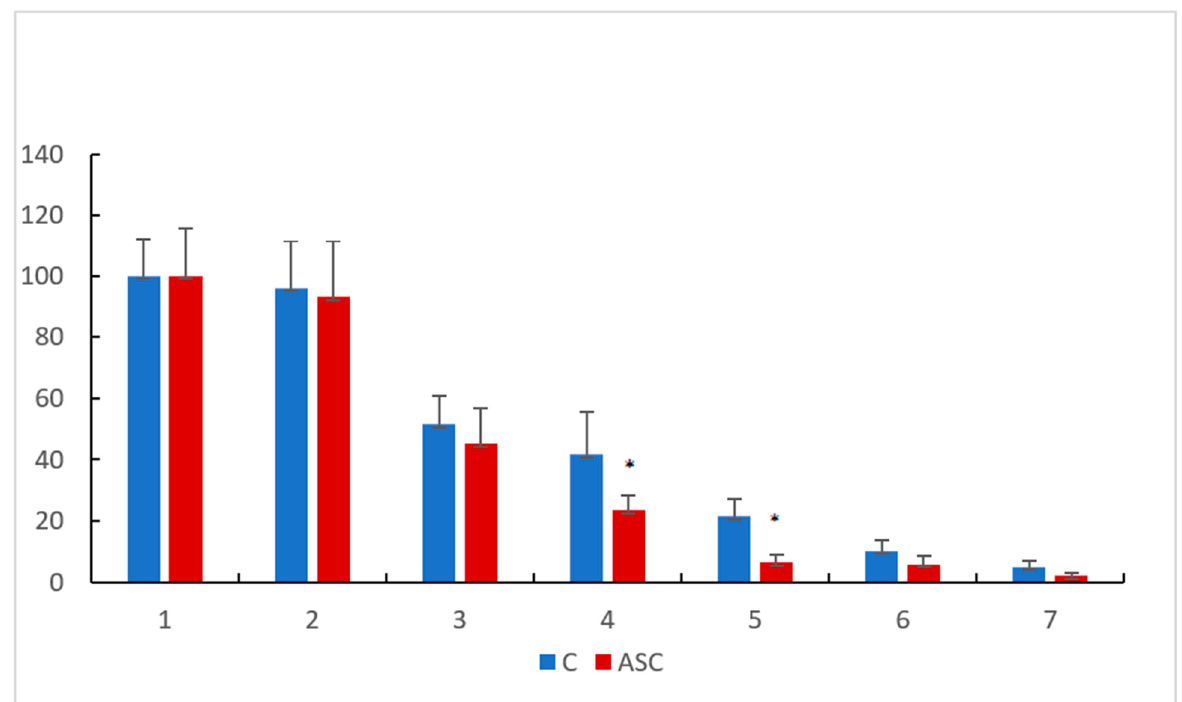
Figure 1. The surface area (in pixels) of the damaged cornea ( Y -axis) vs to time (days, X -axis) staining with fluorescein. The field of primary n -heptanol damage was assumed to be 100%. Red: ASC; blue: control. Number of eyes: 24. *—statistically significant.